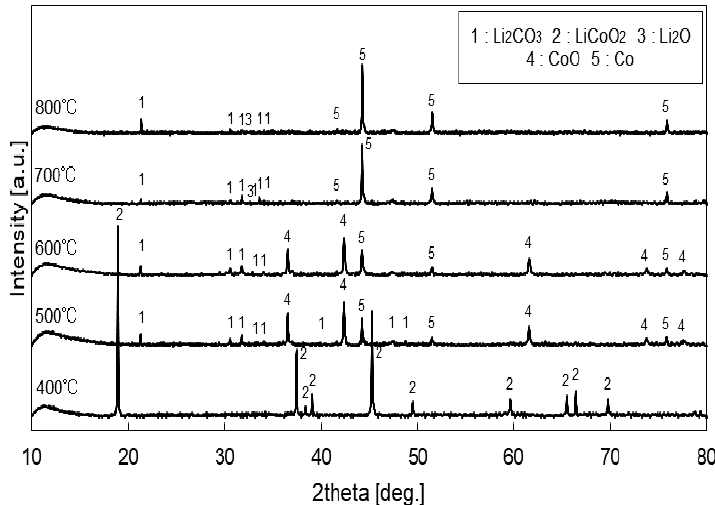
Figure 3. XRD profiles of cathode model samples after calcination.